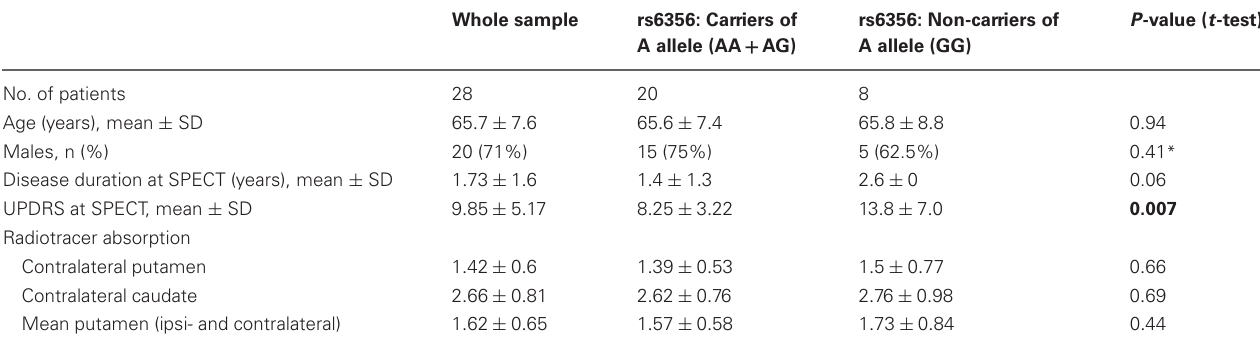
Table 1 | Demographic, clinical, radiotracer uptake values, and descriptive statistics of the whole sample and of carriers and non-carriers of the rs6365 SNP.